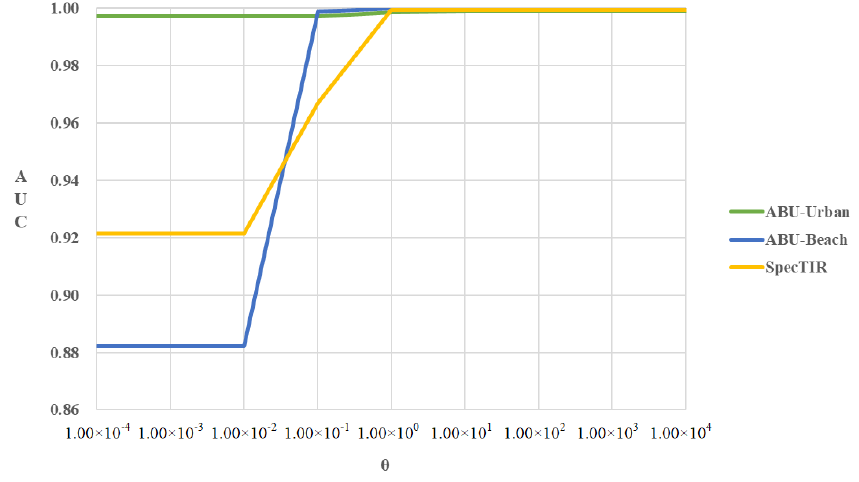
Figure 13. Tuning θ of the proposed LRSNCR.